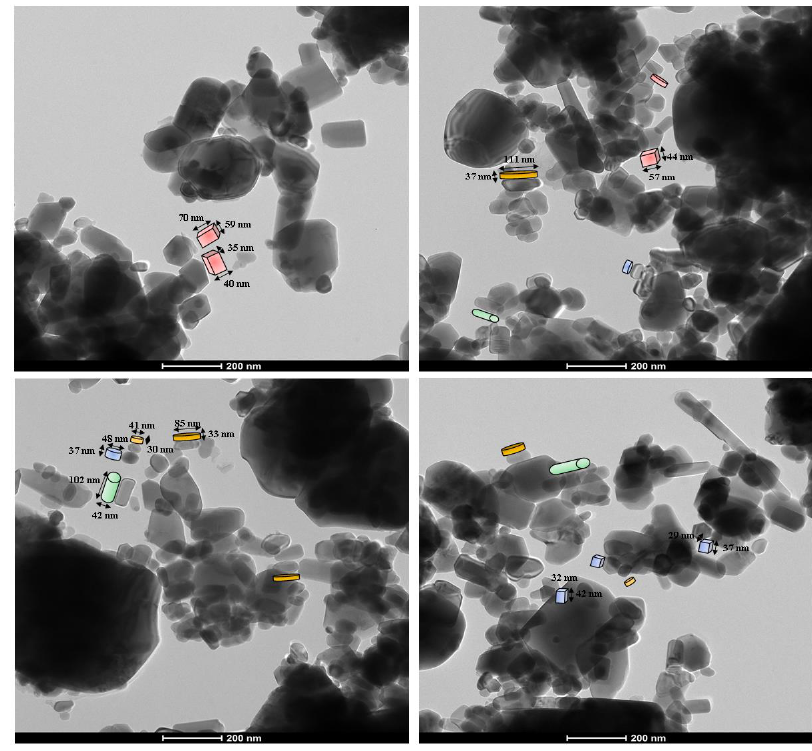
Figure 6. TEM images of the biosynthesized ZnO nanoparticles.